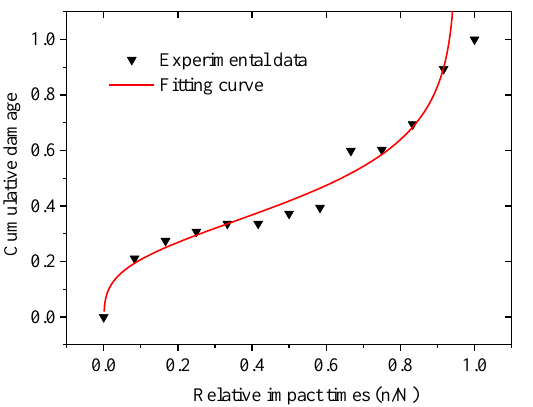
Figure 10. The fitting curve of cumulative sandstone damage under repeated impacts.